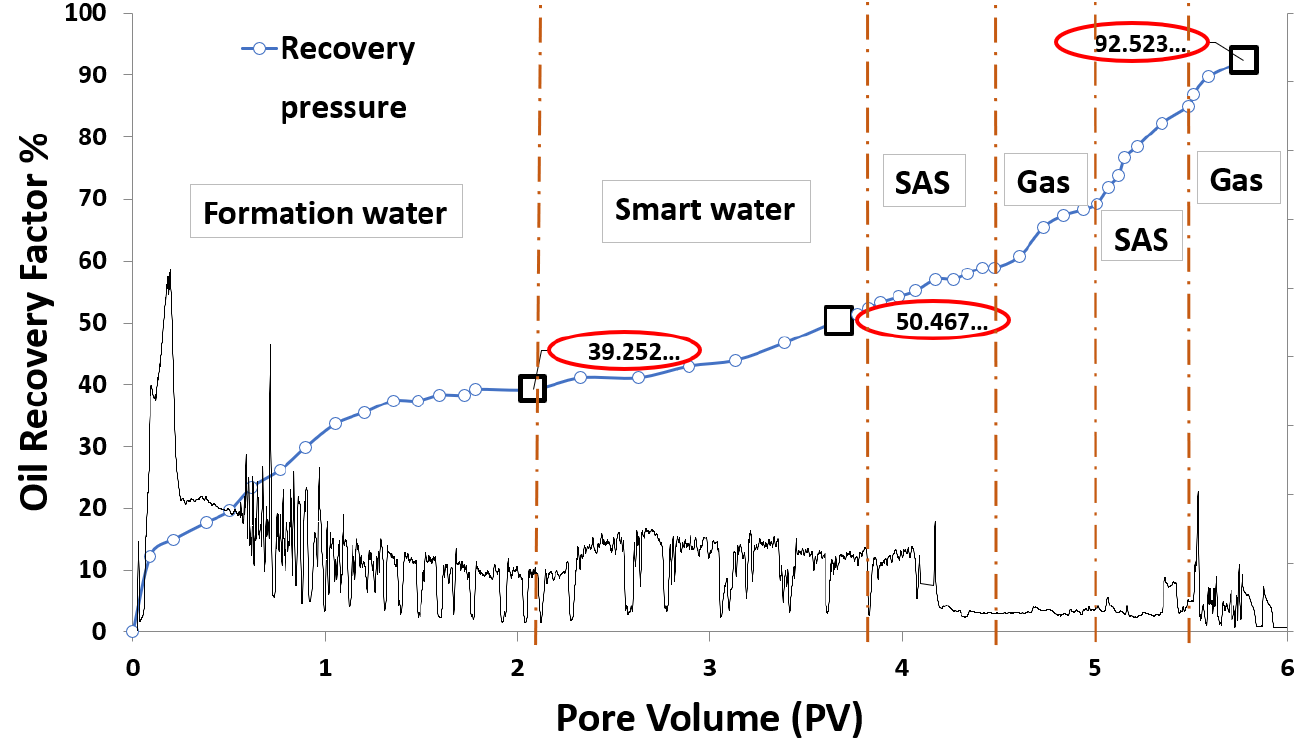
Figure 33. Smart water-assisted foam (SWAF) injection process for the best case scenario (i.e., MgCl 2 ), The method works as an improved/enhanced (IOR/EOR) recovery method for the ionically-modified brine, which goes up to 39% RF for the primary stage (i.e., formation water), 11% RF (i.e., 50% cumulative OIIC) for the secondary stage (i.e., smart water injection), and 92% cumulative OIIC for the tertiary stage (SAG injection i.e., SAS, gas, SAS, and